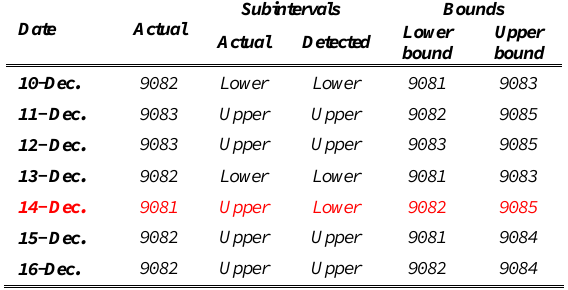
Table 4 Obtained results of the probabilistic neural network and proposed model for test data set in stage IV * Subintervals